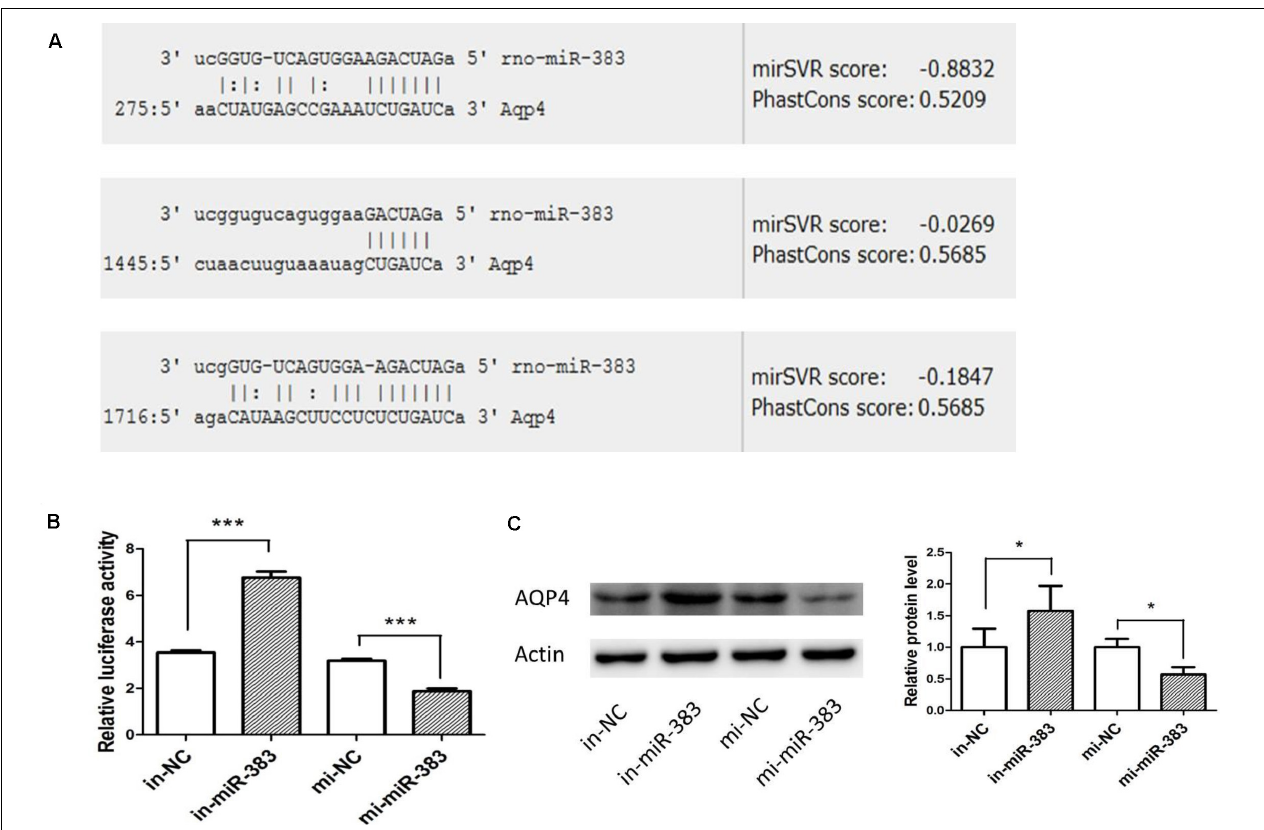
FIGURE 4 | miR-383-5p directly targets AQP4 in glioma cells. (A) Sequence alignment of rat miR-383-5p with 3 (cid:48) -UTR of AQP4. The seed sequences of miR-383-5p (up) and 3 (cid:48) -UTR of AQP4 (down) are complementary. (B) The effect of mimics-miR-383-5p, inhibitor-miR-383-5p, and NC on luciferase activity in C6 cells transfected with the AQP4 3 (cid:48) -UTR reporter ( n = 3), *** p < 0.001. (C) Effect of mimics miR-383-5p (mi-miR-383), inhibitor miR-383-5p (in-miR-383), and NC (mi-NC or in-NC) on AQP4 protein level by western blot analysis ( n = 4). The samples derive from the same experiment and the blots were processed in parallel, * p <